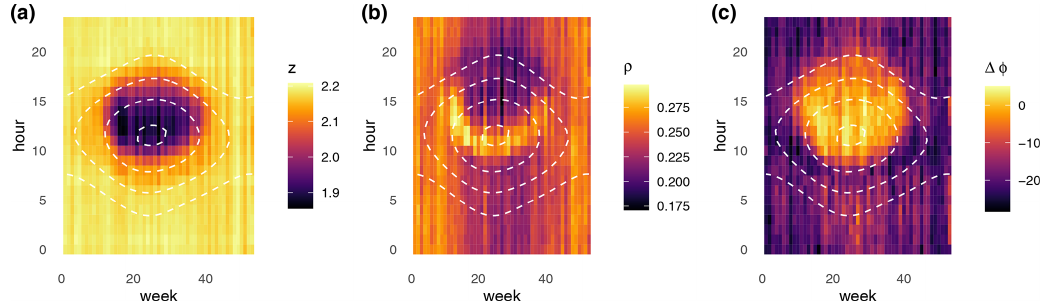
Figure 4. Average central scale (a) , anisotropy (b) , and angle relative to the mean wind (c) ,calculated from COSMO-REA2 (2007–2013) in the environment of the selected radar stations. White contours mark the sun’s elevation angle at 0, 20, 40, and 60 ◦ .